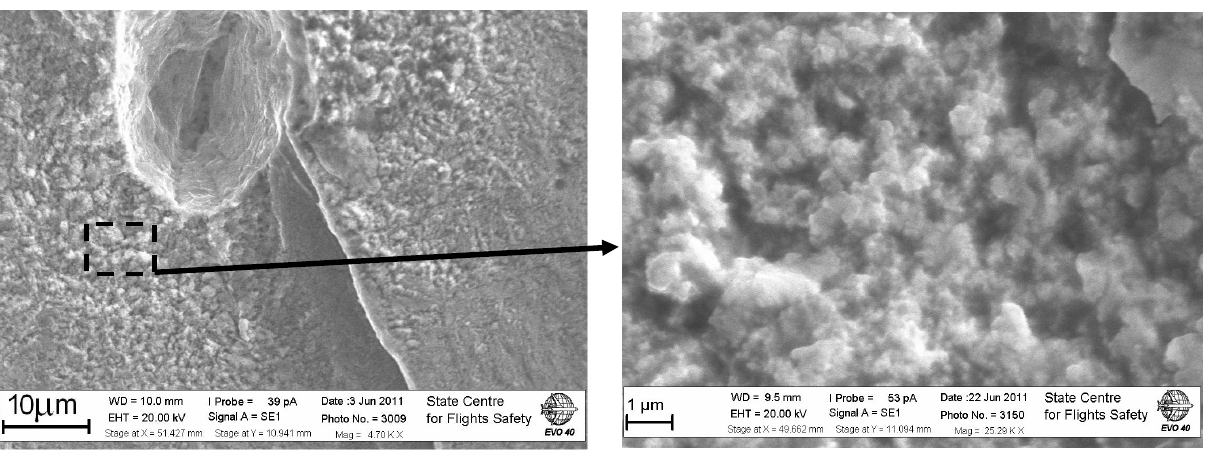
Figure 1: View of Fine-Granular-Area under high magnification [13]. Spherical particles are dominant of the surface pattern.